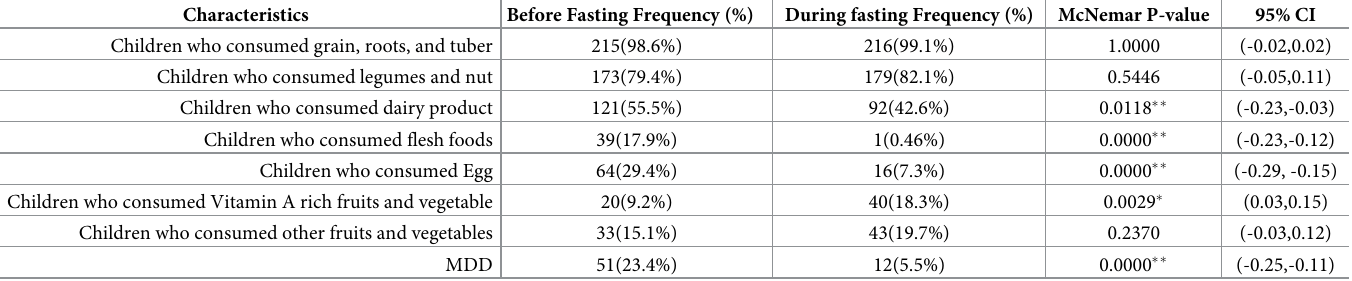
Table 4. Comparison of food consumption pattern of 6–23-month-old children during the non-fasting and lent fasting periods in Debrebirhan, North Shewa Ethio- pia, 2019.